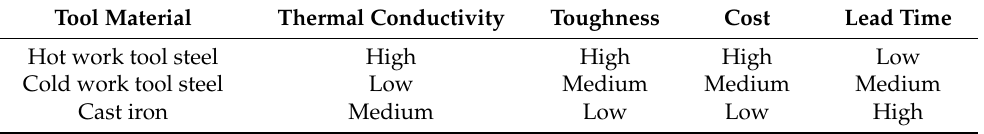
Table 1. Summary of the preliminary comparison of the three studied tool material alternatives.